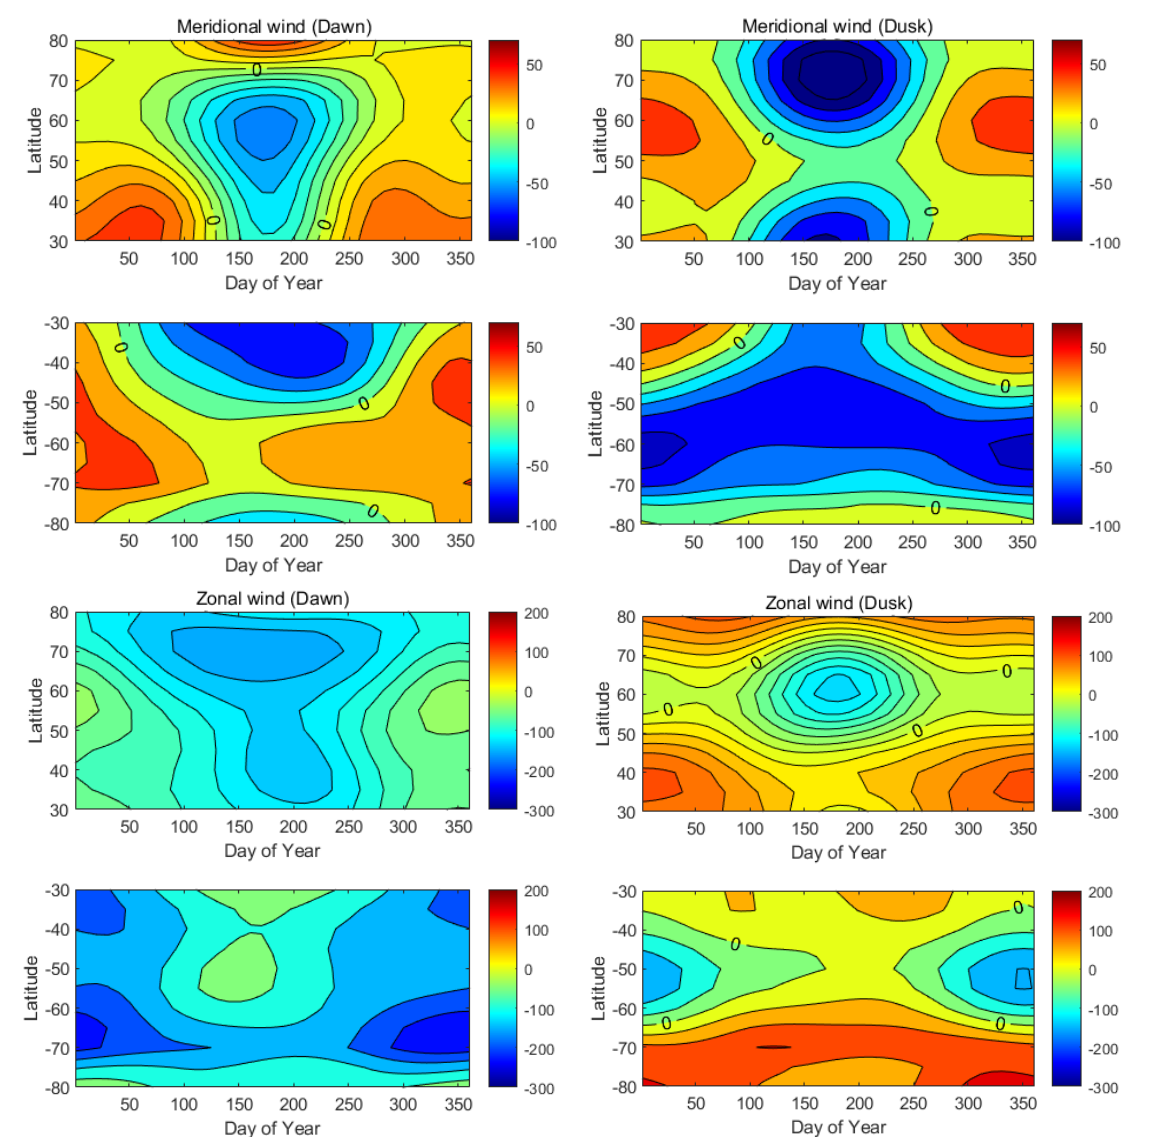
Figure 4. The latitudinal and seasonal variations of meridional (upper) and zonal (lower) wind at altitudes between 210 and 320 km at 0730LT ( left ) and 1930LT ( right ) from the HL-TWiM model. Figure 5 shows the seasonal variation of ∆ ρ rmax and ∆ ρ rmin from APOD at dawn and dusk. The left panel shows that the annual maximum of ∆ ρ rmax from APOD occurs in July at both dawn and dusk. Xu et al. [10] showed that the annual maximum of ∆ ρ rmax from the GRACE observations occurred during equinoxes. The difference in peak occurrence time may be due to the different solar activity levels and local times. The results in Xu et al. [10] are averaged over all local times at high, middle, and low solar activity levels. The results from APOD in the paper are only for around the terminator at a low solar activity